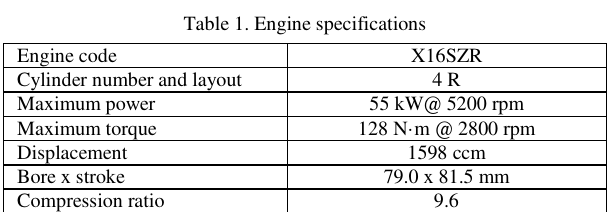
Table 1. Engine specifications